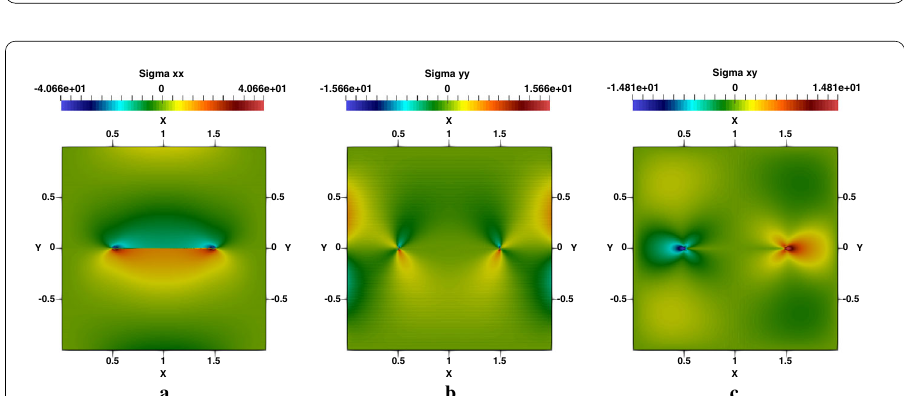
Fig. 6 Square plate with a centred crack, a / W = 0 . 5: a σ xx -stress, b σ yy -stress, c σ xy -stress